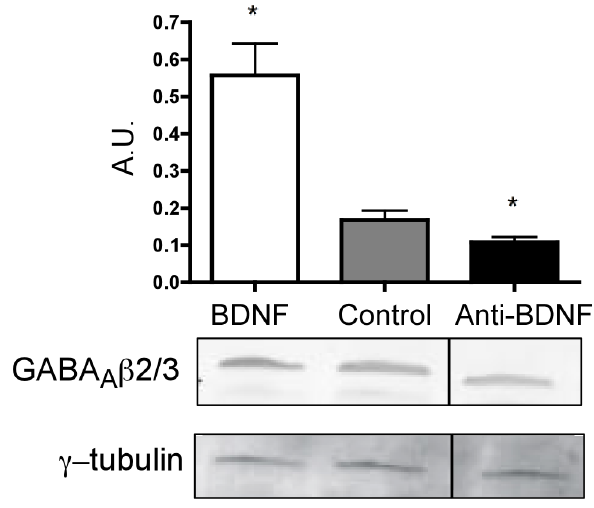
Figure 3. Manipulation of BDNF signaling affects the expres- sion of GABA receptors in A1. Expression of GABA A b 2/3 subunits measured using quantitative immunoblotting in the different rat groups (3 animals per group). The insert shows a representative western blot. Values are means 6 SEM. * significantly different than control rats at p ,